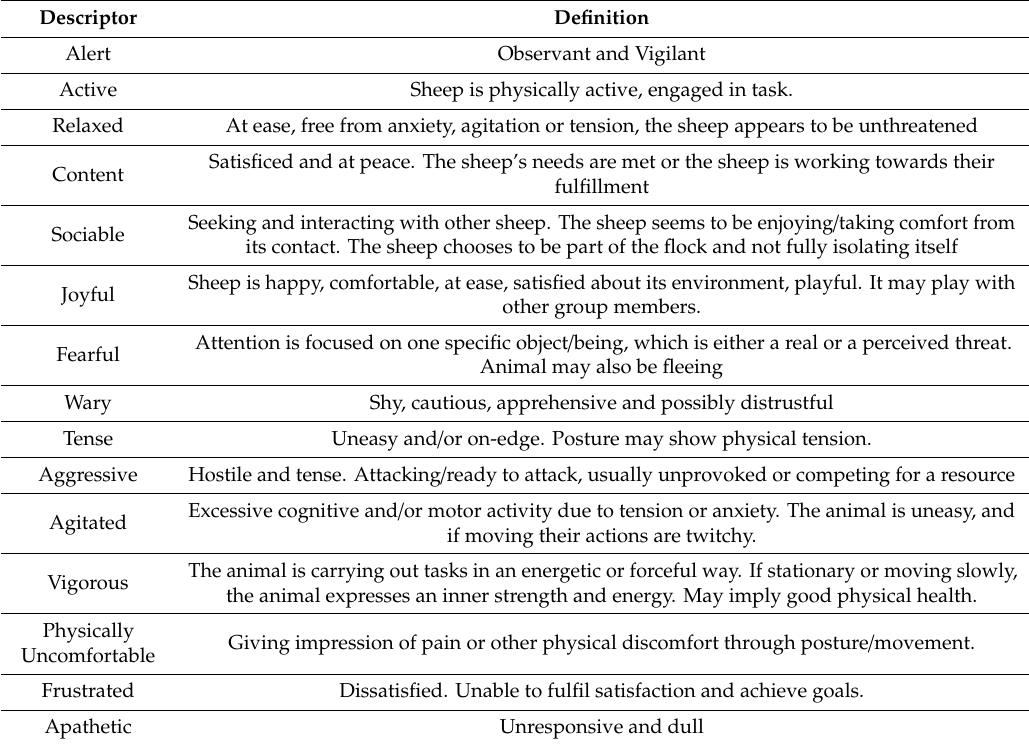
Table 1. Selected descriptors and definitions for the QBA assessment in grazing sheep, Marulanda, Caldas